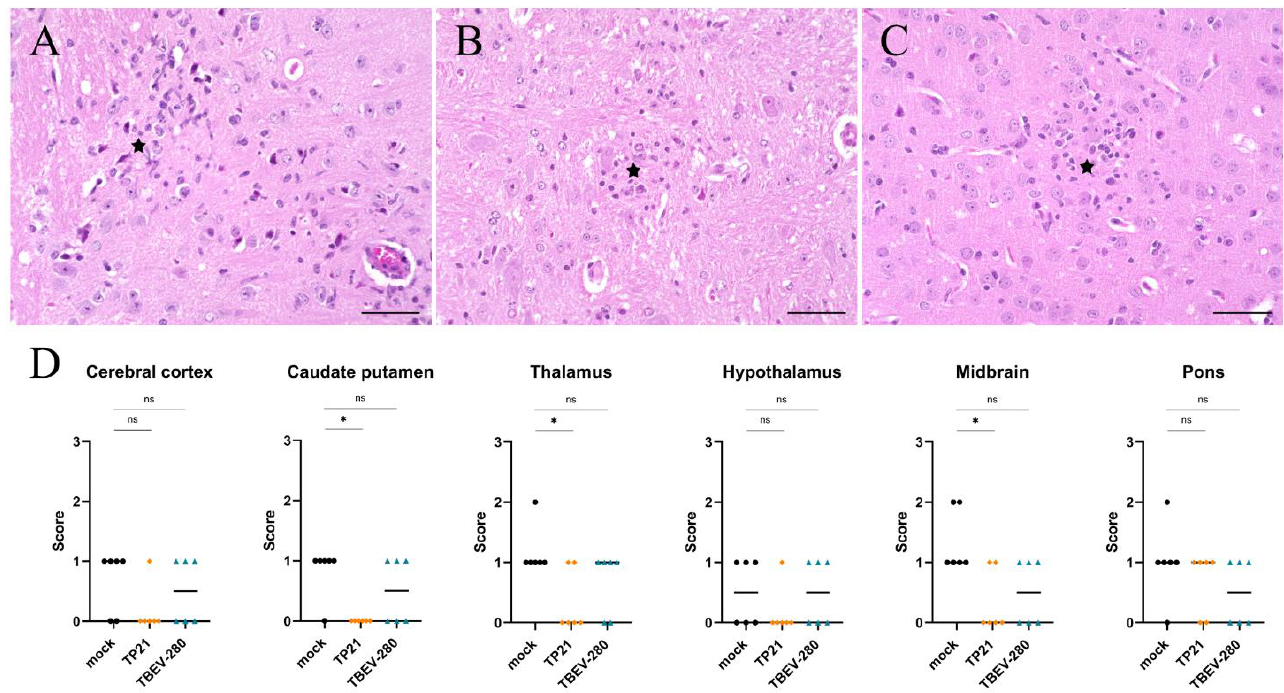
Figure 6. Reactive changes in the brain following TBEV-Hypr challenge. Gliosis (star) was detected in the brain of mock ( A ), TP21 ( B ) and TBEV-280 ( C ) immunized mice that were subjected to TBEV-Hypr challenge; scale bars 50 µ m. ( D ) Gliosis was scored on a scale of 0–3 (see methods) by screening HPF from different brain regions of mock ( • ), TP21 ( (cid:7) ) and TBEV-280 ( (cid:78) ) immunized mice. Dots represent individual animals, bars indicates mean value ( n = 6; * p < 0.05, ns = not